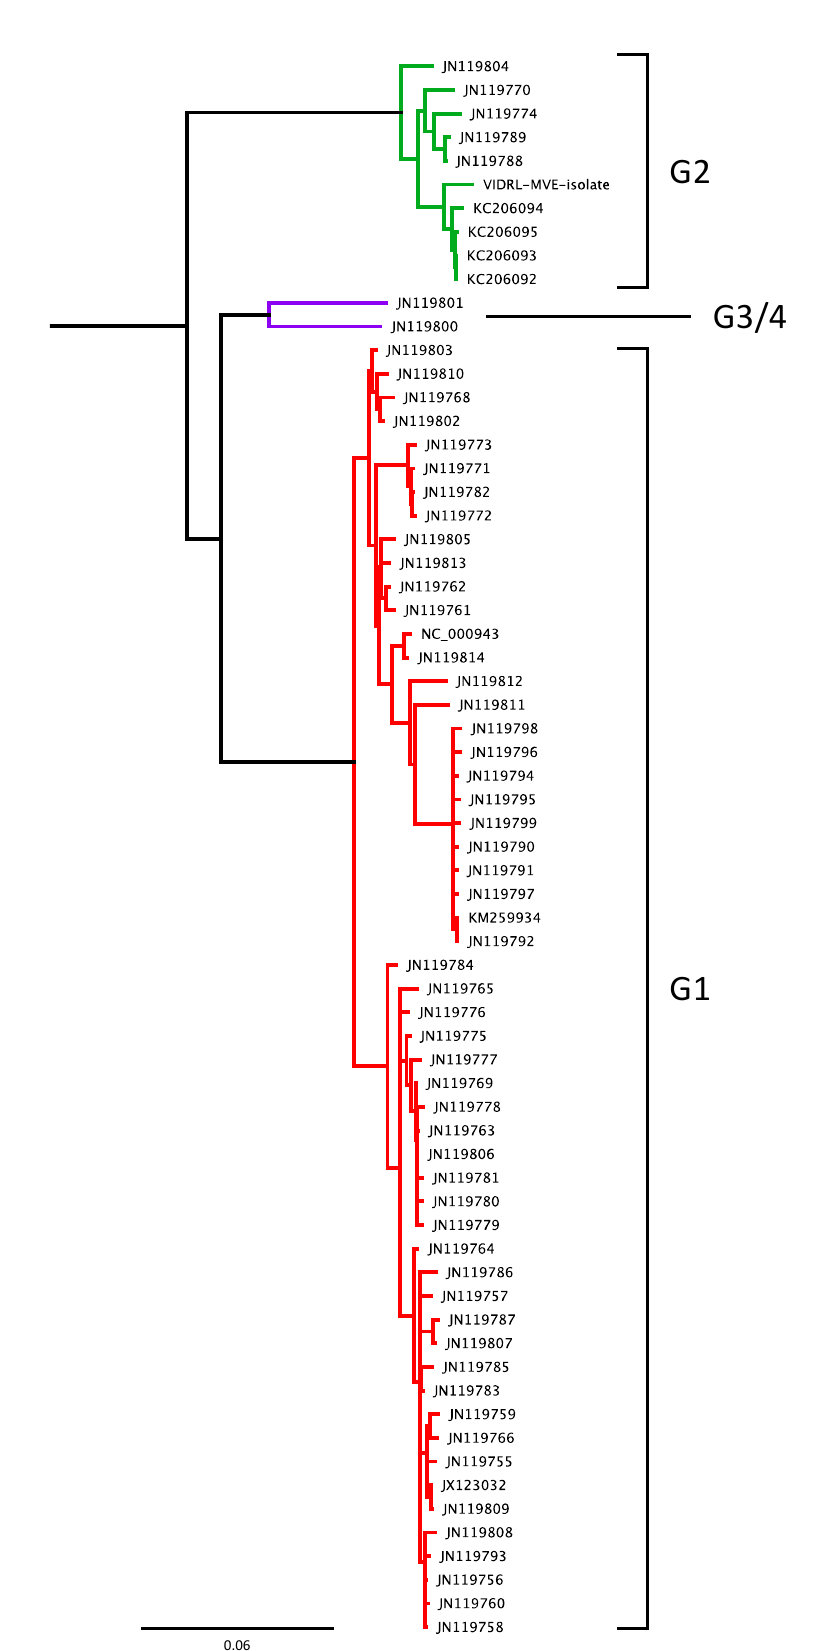
Figure 2. Neighbor joined tree of MVEV prM-E sequences confirm VIDRL-MVEV as Genotype 2. Viral genotype (G1–G4) is indicated. Scale bar indicates 0.06 nucleotide substitutions per site.